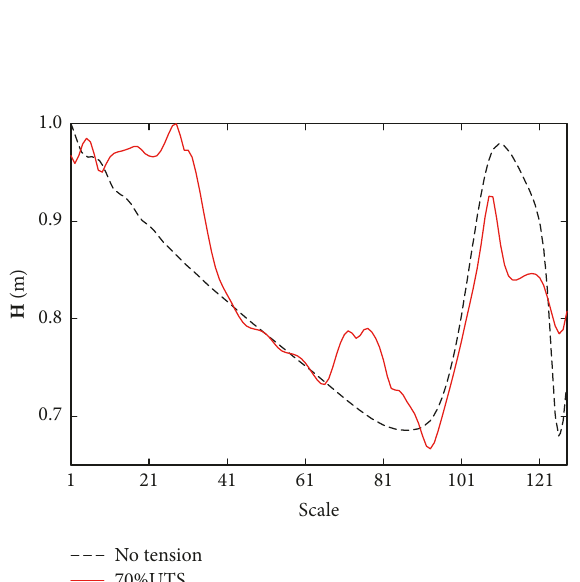
Figure 5: Scale energy entropy spectrum ( H ) for no tension and 70% UTS cases.